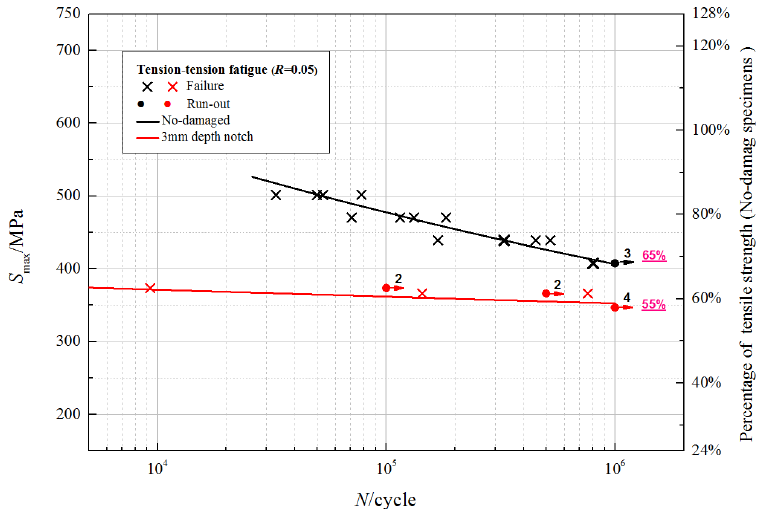
Figure 7: Tension-tension fatigue S - N curve of specimens with no-damaged and 3mm depth double-edge notches damage